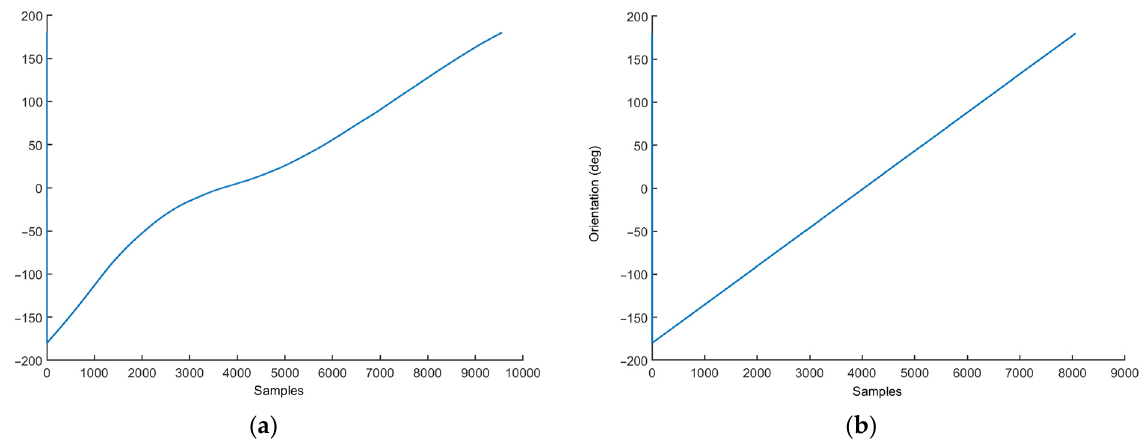
Figure 6. The orientation (azimuth) of a smartphone placed on slowly rotating, electric-powered platform, calculated by a MATLAB script, using ( a ) all sensor data and ( b ) only the accelerometer and gyroscope data, but not the magnetometer data.